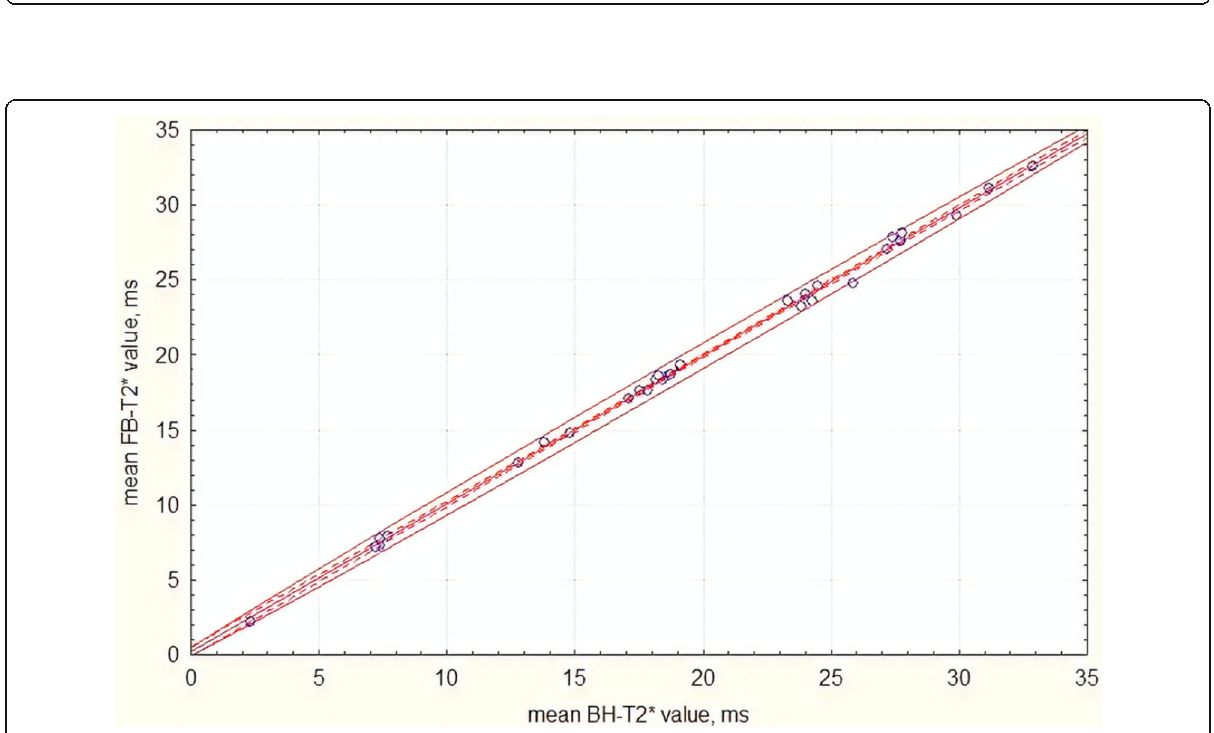
Fig. 6 Scatterplot of T2* values obtained using free-breathing (FB) and breath-holding (BH) sequences ( n = 32; r = 0.99; R 2 = 0.98; p < 0.001). Continuous thin lines show the 95% confidence